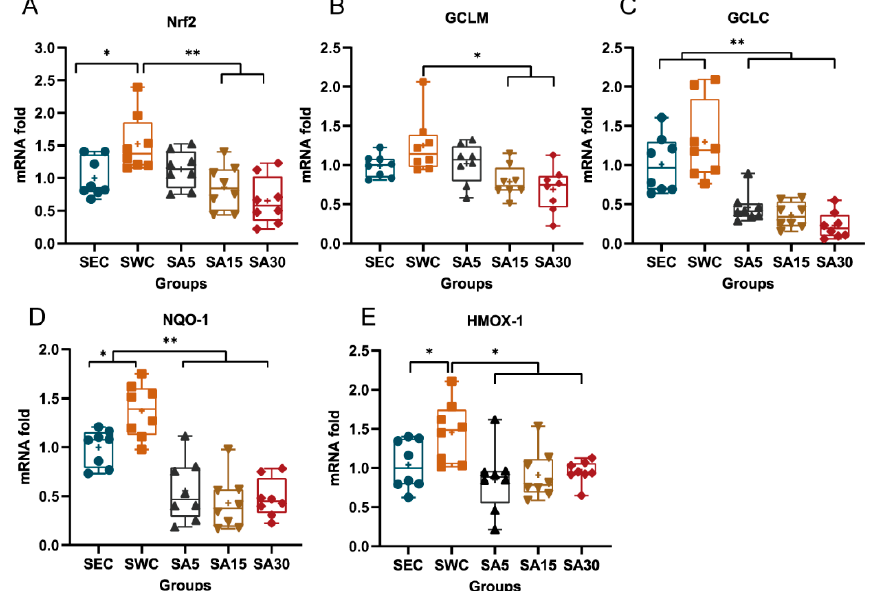
Figure 4. Effects of astaxanthin on transcription of Nrf2 and Nrf2-dependent enzymes in swimming training mice heart. ( A ) exhibits mRNA levels of Nrf2 among different groups, ( B ) presents GCLM transcriptional levels among different groups and ( C ) exhibits GCLC transcriptional levels among different groups. ( D ) shows NQO-1 transcriptional level among different groups and ( E ) shows HMOX-1 transcriptional level among different groups. Values are expressed as Box-and-Whisker plots, in which the bottom and top of the box present the first and third quartile, respectively; the band inside the box is always the second quartile (the median); lines extending vertically from the boxes (whiskers) stand for the upper and lower extreme (the highest and lowest number in a set of data), and plus signs indicate the mean for each group. The symbol * indicates a significant difference at p < 0.05, and ** indicates a significant difference at p < 0.01.